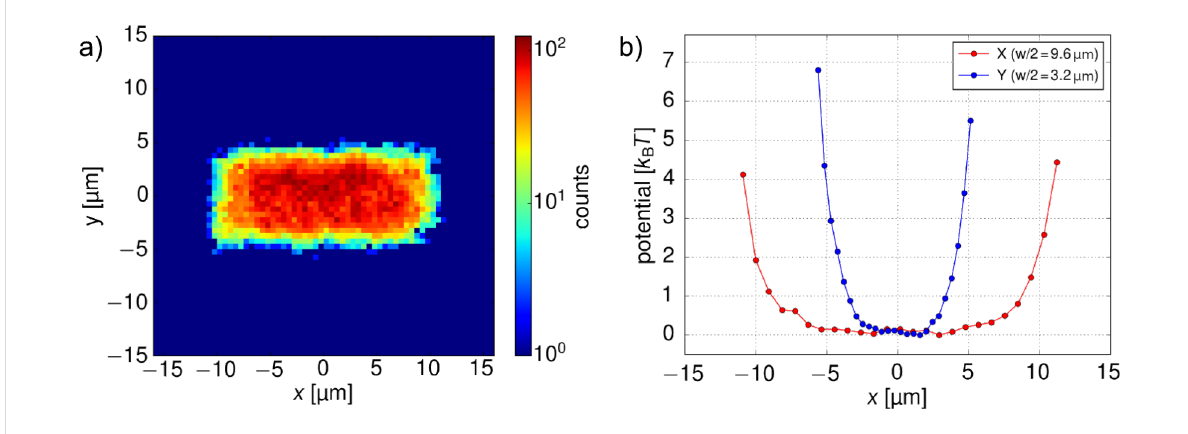
Figure 4: Example of a tailored nanoparticle trap. Preset feedback rules result in a creation of a 20 × 10 μ m 2 potential well for a single 200 nm parti- cle. (a) 2D histogram of particle positions. (b) Cross section of the effective potential in x - and y -directions.